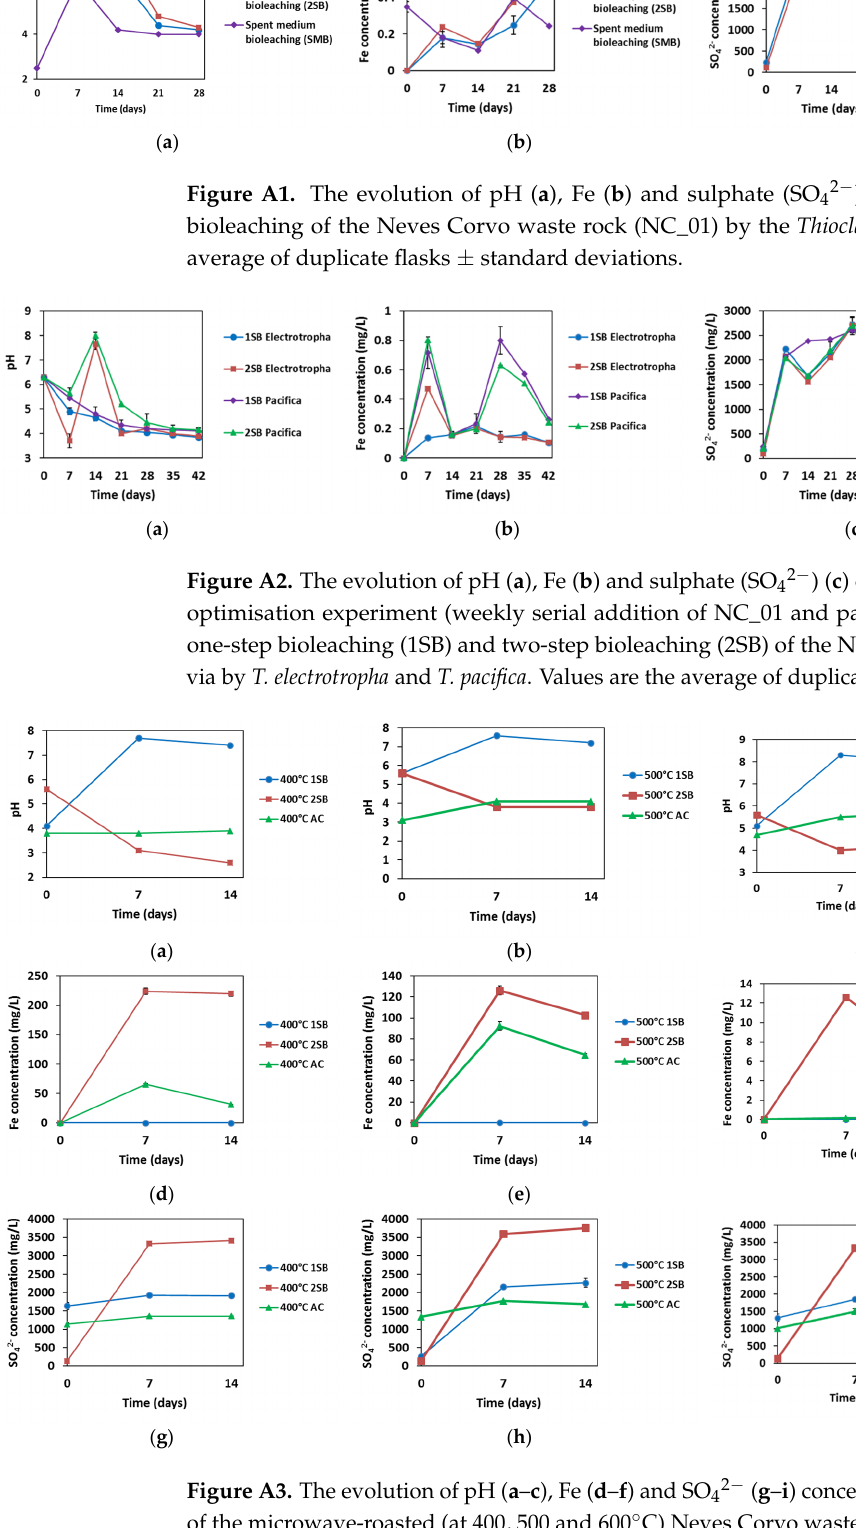
via one ‐ step bioleaching (1SB), two ‐ step bioleaching (2SB) and the abiotic control (AC). Values are of the microwave-roasted (at 400, 500 and 600 ◦ C) Neves Corvo waste rock (NC_01) by T. electrotropha the average of duplicate flasks ± standard deviations. via one-step bioleaching (1SB), two-step bioleaching (2SB) and the abiotic control (AC). Values are the